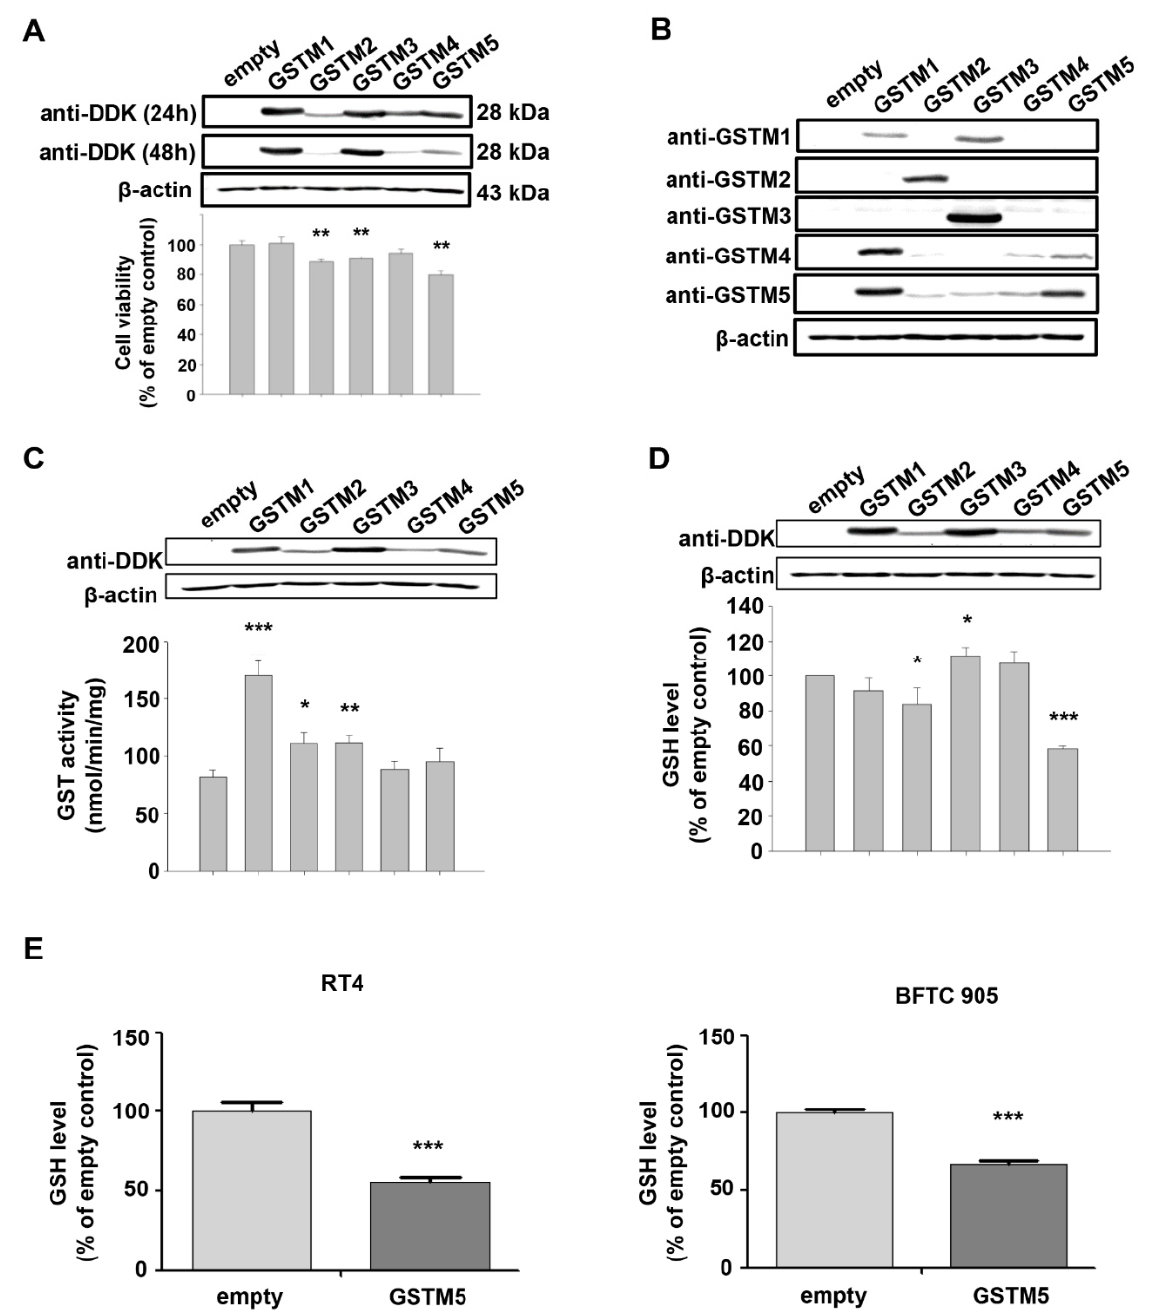
Figure 3. The expression and biological effects of GSTM1-5 by transient transfection expression. ( A ) The protein expression and cell viability after transfection. A total of 5637 cells were transfected with empty vectors or vectors with GSTM1-5 genes. After transfection for 24 h and 48 h, the proteins were detected by anti-DDK antibodies. Cell viability was analyzed after transfection for 32 h. ( B ) The protein expression and antibody characteristics. A total of 5637 cells were transfected with empty vectors or vectors with GSTM1-5 genes for 24 h; GSTM1~5 proteins were detected by their individual antibodies from GeneTex. ( C ) GST activity assay. A total of 5637 cells were transfected with empty vectors or vectors with GSTM1-5 genes for 24 h, the protein expression and GST activity were analyzed individually. ( D ) Cellular GSH level. A total of 5637 cells were transfected with empty vectors or vectors with GSTM1-5 genes for 24 h, the protein expression and GSH level (assayed by Cayman Chemical kit 703002) were analyzed. ( E ) Cellular GSH level in RT4 and BFTC 905 cells. After transient transfection for 24 h, cells were collected for GSH level detection (assayed by Cayman Chemical kit 703,002). All data are presented as the mean ± SE of three independent experiments. * p < 0.05; ** p < 0.01; *** p <